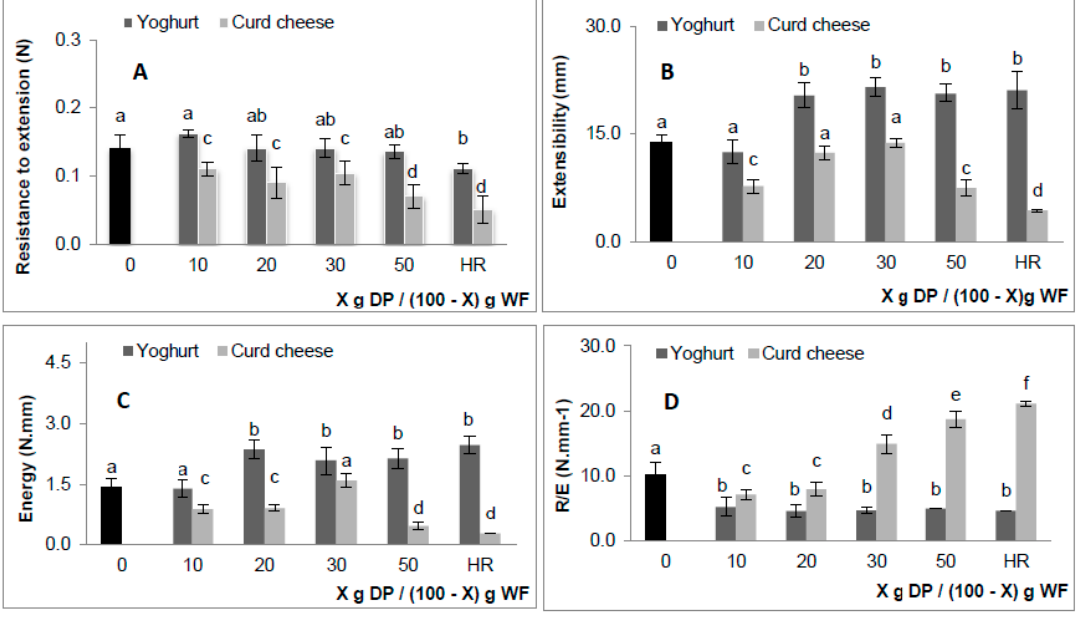
Figure 1. Effect of the Yg and Cc incorporation, after 60 min of fermentation time at 30 °C , on the extension properties of the dough, in terms of: ( A )—resistance to extension (N), ( B )—extensibility (mm), ( C )—deformation energy (N.mm -1 ) and ( D )—ratio R/E (N.mm -1 ), with different levels of dairy product (DP) additions: 10, 20, 30, 50, and higher replacements (HR) tested—70 g for Yg and 83 g for Cc—compared with control dough (0 g/100g). Different letters indicate statistically significant differences at p < 0.05 (in Tukey test), compared with the control dough parameters (black bars).